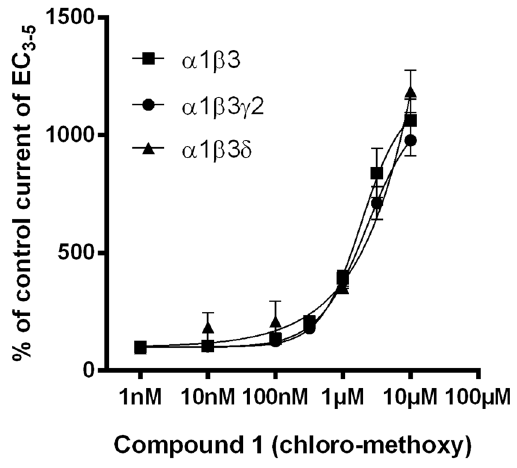
Figure 2. Compound 1 modulates GABA-evoked currents from α 1 β 3, α 1 β 3 γ 2 and α 1 β 3 δ similarly. Concentration-dependent modulation of GABA EC 3–5 current at α 1 β 3, α 1 β 3 γ 2 and α 1 β 3 δ . Data represent means ± SEM (n = 3–8). α 1 β 3 and α 1 β 3 γ 2 data are identical with those published previously 22